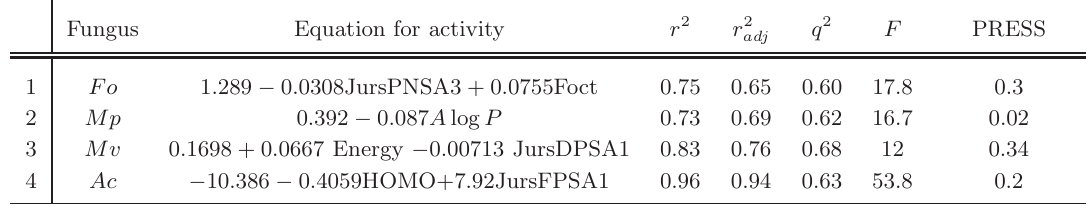
Table 3 QSAR for various fungal activities.